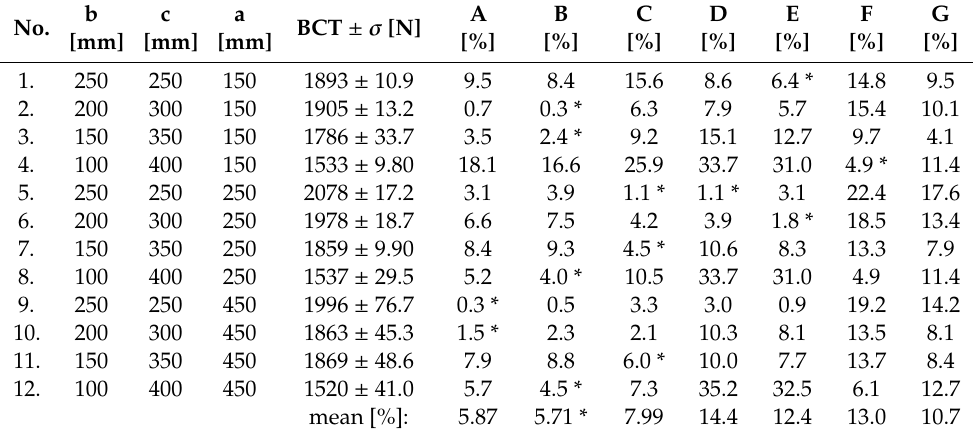
Table 3. Experimental data (dimensions and box compression strength) and computational errors according to di ff erent analytical approaches (see Table 1) for 3B400 cardboard quality; for cases A–E k = 0.5 and r = 0.75; for case F ˆ k = 2.028 and r = 0.746; for case G ˇ k = 5.874 and r =